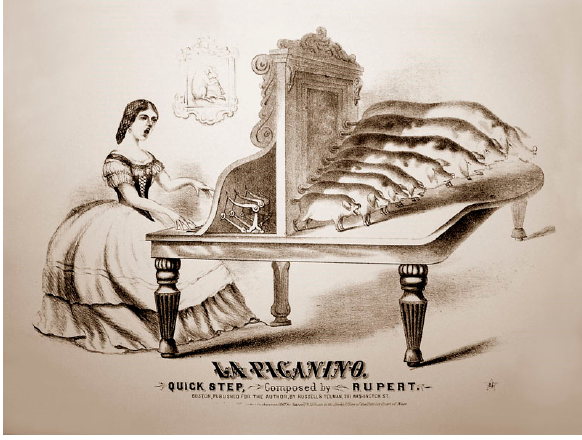
Figure 1. Pig Organ, cover illustration for the piece of sheet music “La Piganino” [22].